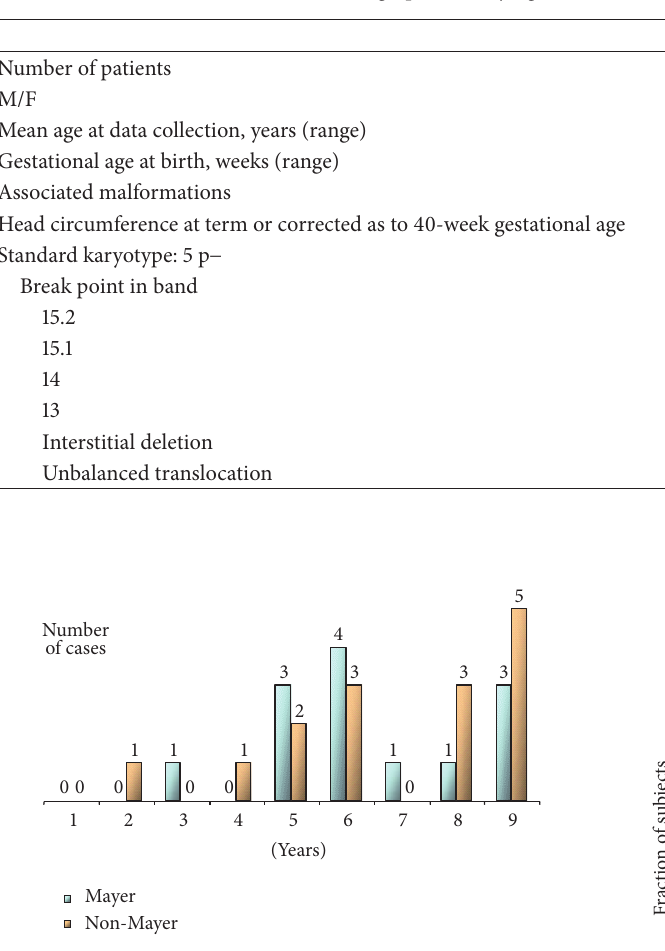
Table 1: Demographic and cytogenetic features of the two groups of CdCS patients.